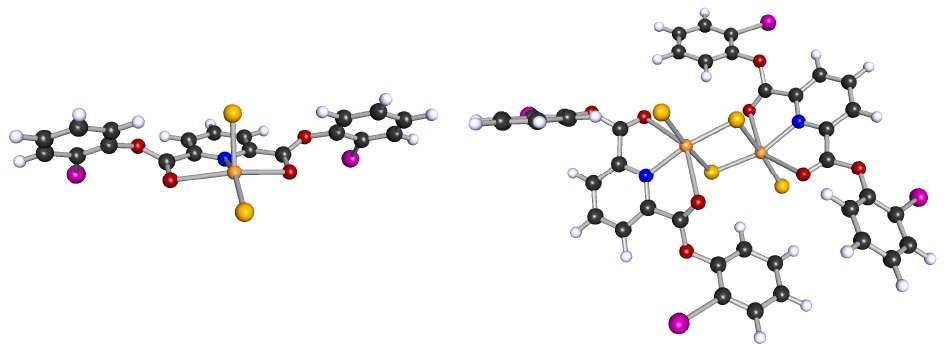
Figure 1. DFT-calculated optimized geometry of mononuclear [Cu(pydic(IPh) 2 )Cl 2 ] ( left ) and binuclear [{Cu(pydic(IPh) 2 )Cl} 2 (µ-Cl) 2 ] ( right ). Calculated at the def-SV(P)/B3LYP level.